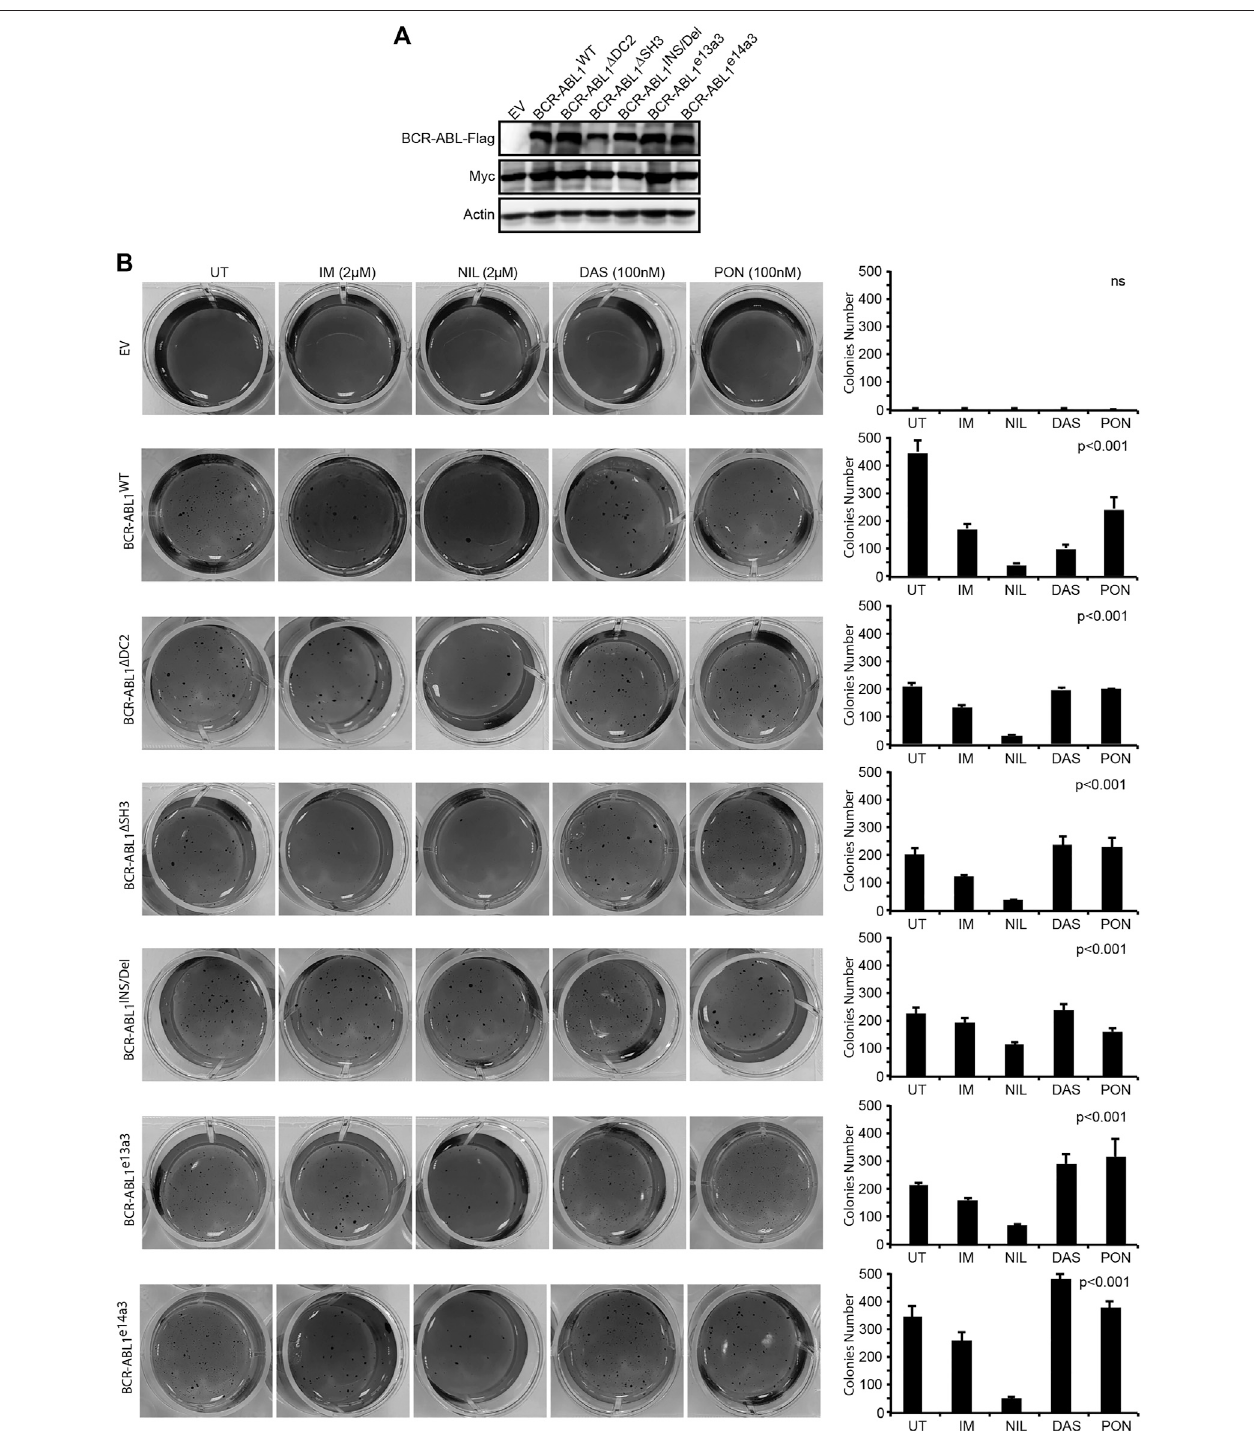
FIGURE 4 | Uncommon breakpoint regions in fl uence BCR-ABL1-dependent defective adhesion and show high sensitivity to NIL in Rat1 cells. (A) Immunoblots of Rat1 cells transduced with the indicated constructs. Protein lysates were obtained and processed as detailed in Figure 2 . Actin was used as loading control. (B) Image showing colony formation in soft-agar of Rat1 cells expressing the indicated constructs. Bars report the standard deviations obtained from two independent experiments.